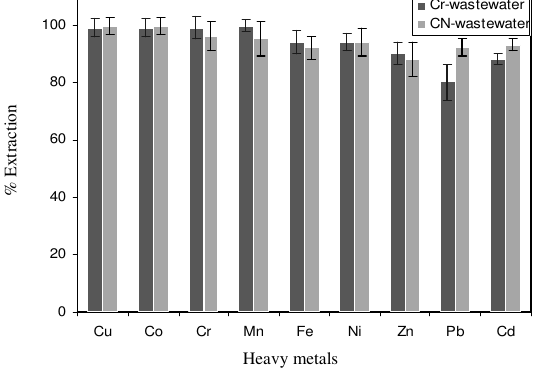
Figure 3. Heavy metal removal from chromium, cyanide and acid/alkali wastewater by PHA-PA ligands, Column condition: Column bed 20 cm, conditioned at pH 4, diameter of glass column 20 mm, flow rate 5